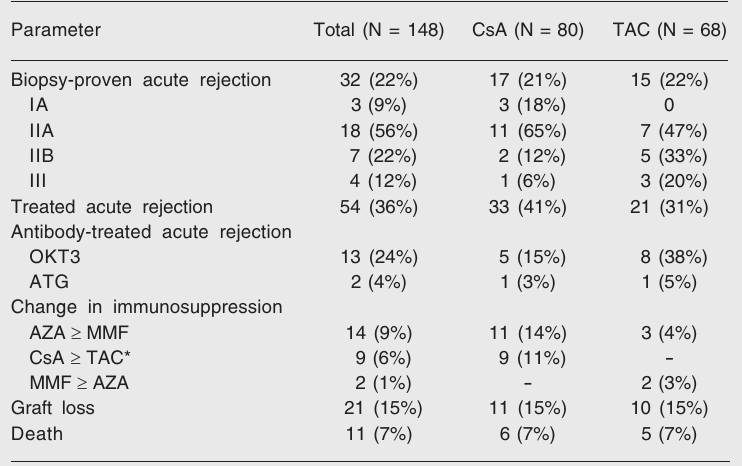
Table 4. Efficacy on